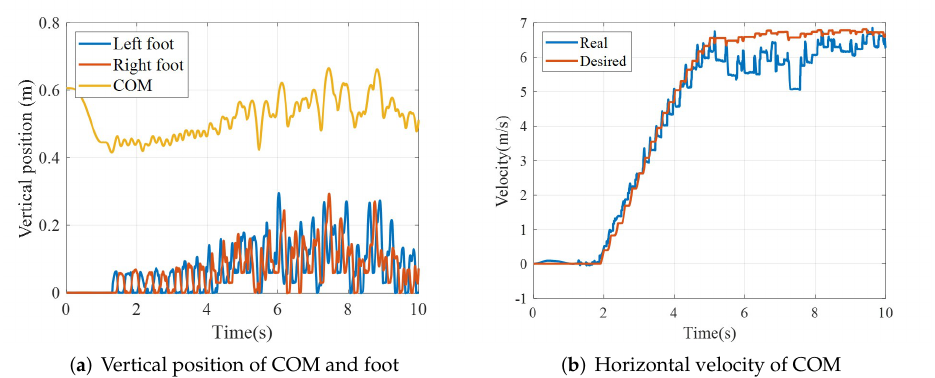
Figure 14. Simulation of running on the ground with randomly distributed obstacles (Case